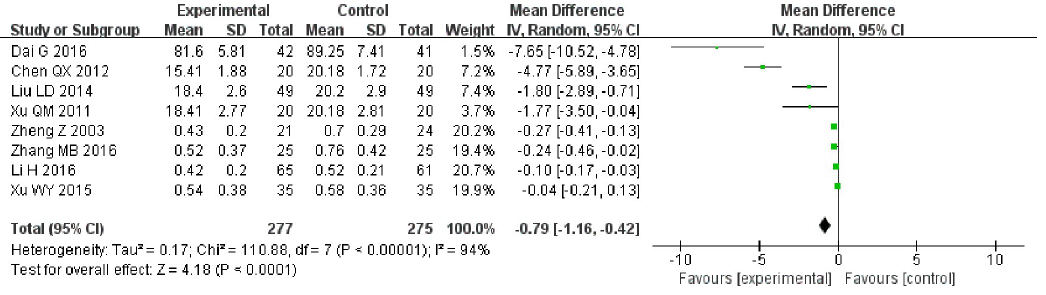
Fig 3. Forest plot for 24 h urinary